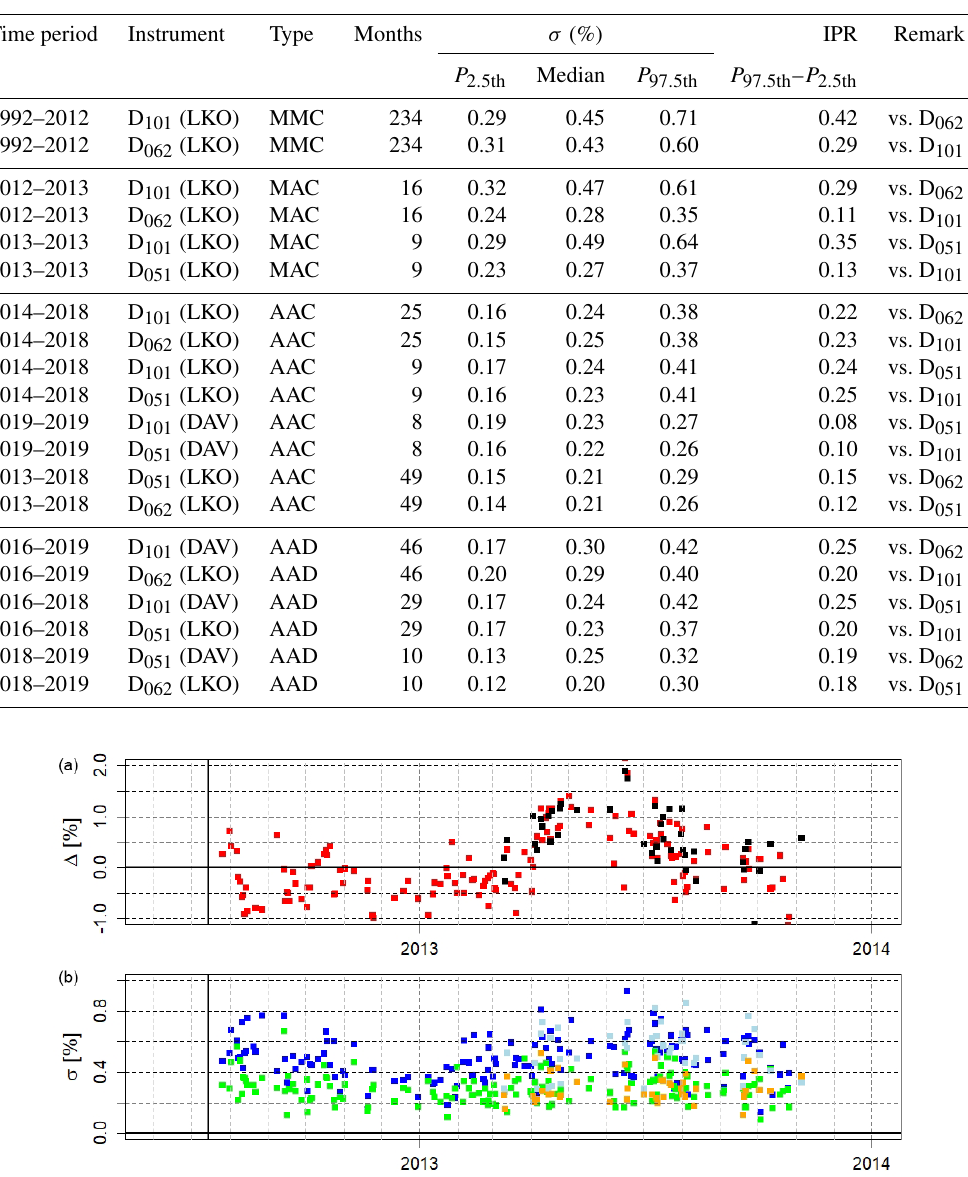
Figure 6. (a) 2012–2013 time series of (cid:49) 062–101 (red) derived from coincident measurements of D 101 (manual) and D 062 (automated) and (cid:49) 051–101 derived from coincident measurements of D 101 (manual) and D 051 (automated) for 2013 (black). (b) Time series of σ i of D 101 (blue and light blue), D 062 (green) and D 051